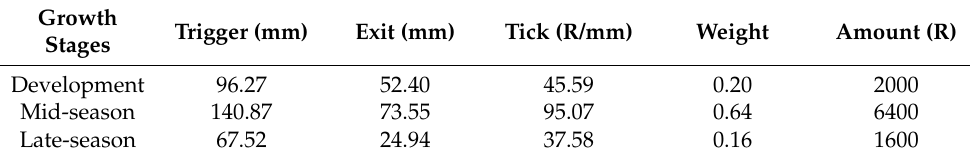
Table 3. Index threshold values for maize planted on 21